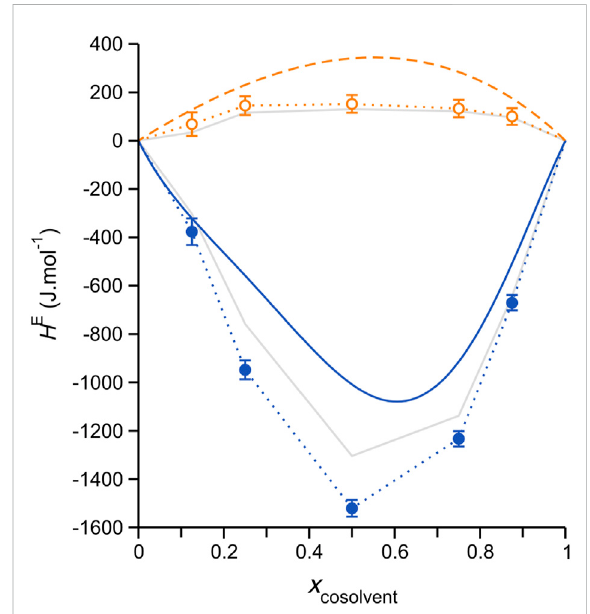
FIGURE 2 Excess molar enthalpies, H E , computed for simulated ChCl/ ethylene glycol (1:2 molar ratio) DES mixtures with either water (blue solid circle markers) or methanol (open orange circles) cosolvent at 308.15 K, plotted as a function of the mole fraction cosolvent. Dotted lines of corresponding color connect the data, serving as guides to the eye; error bars represent one standarddeviation.Thesmoothsolidblueanddashedorangelines are non-random two liquid (NRTL) model fi ts to the experimental H E data reported by Ji and coworkers (Ma et al., 2016; Ma et al., 2017; Wang Y. et al., 2020). The experimental errors for the mixtures with water are 5 – 10% (Ma et al., 2016) and those for the mixtureswithmethanolareabithigherdependingontheabsolute value, with maximum errors up to 15% (Wang Y. et al., 2020). Solid grey lines without data markers show the H E computed using an alternative component mole fraction de fi nition, which considers the dissociated ChCl ion pair, as discussed in the main text; error bars have also been omitted for these data in the interest of clarity (similar in magnitude to those associated with the circle-marked